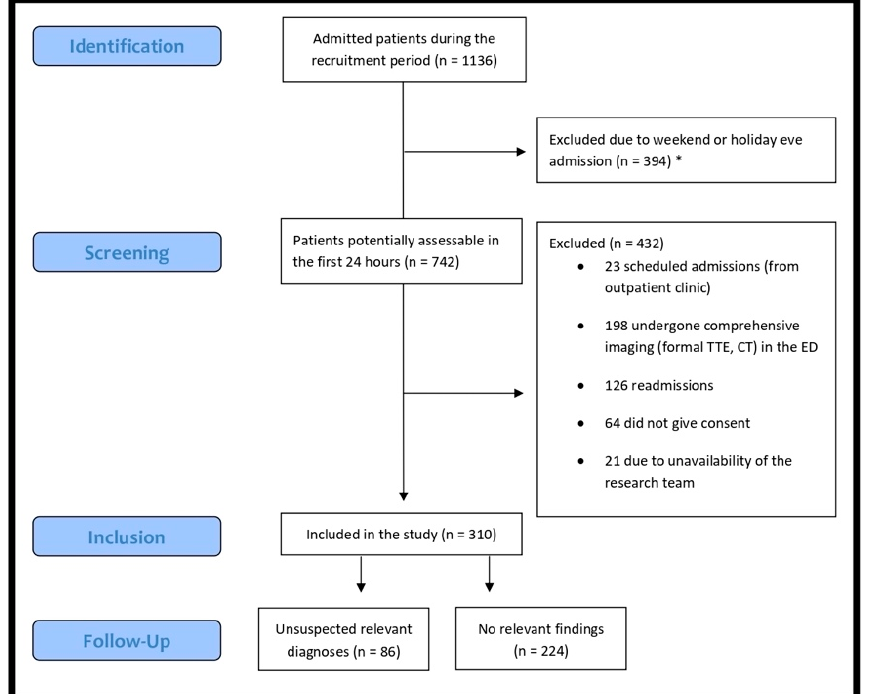
Figure 4. STROBE flow diagram. CT: computed tomography; ED: emergency department; TTE: transthoracic echocardiography. * Impossibility to perform the ultrasound in the first 24 h.